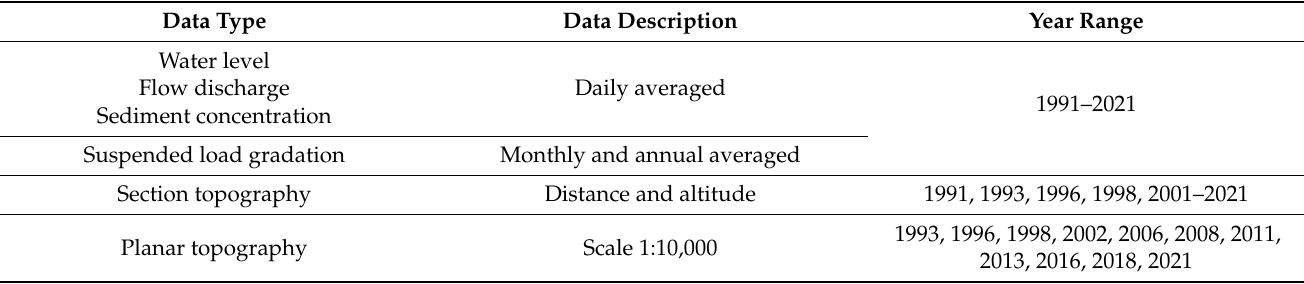
Table 1. Details of the collected